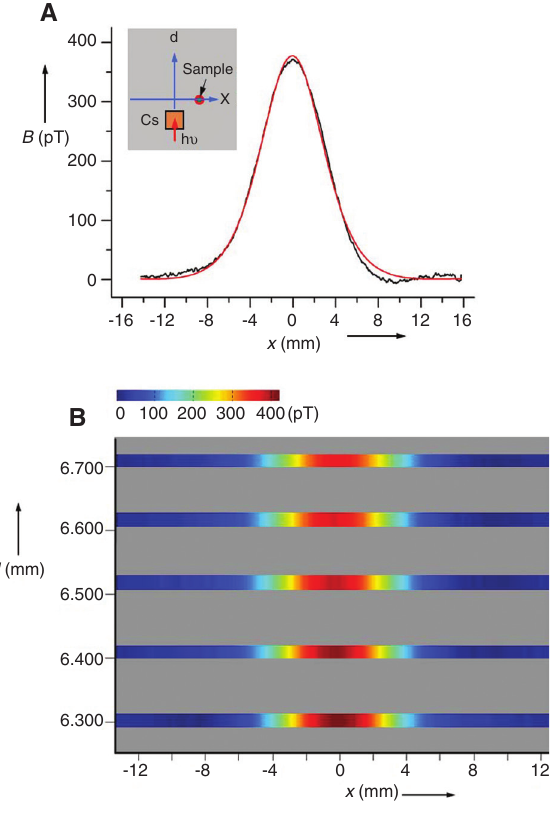
Figure 10 Scanning magnetic imaging of nanoparticles using atomic magnetometer. (A) Magnetic field profile of an assembly of approximately 7 × 10 5 magnetic nanoparticles (experimental data and fitted curve). The inset shows the geometry of the scanning axes with respect to the laser beam and the Cs detector. (B) A two-dimensional scanning magnetic image. Each stripe represents an x-axis scan. The width of each stripe is determined by the corresponding error bar of the fitted d value. (Reproduced with permission from Ref. [162], Copyright John Wiley and Sons, 2009.)